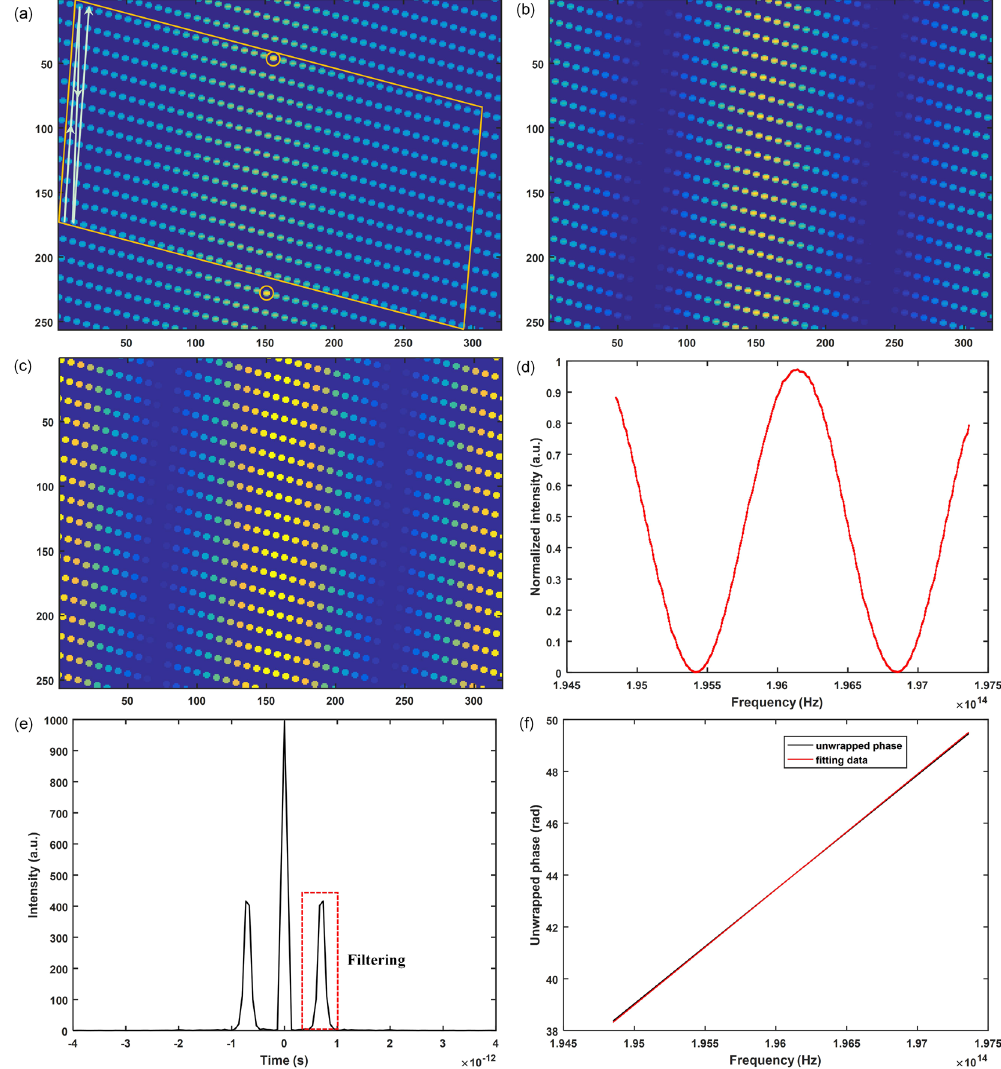
Figure 2. 2D spectrogram and data computing process. ( a ) Camera image of filtered comb spectrum, 1D spectrum is reconstructed by stitching vertical lines inside the orange box together, as indicated with the white arrow. ( b ) Camera image of spectral interferogram at a certain moment. ( c ) Camera image normalized by filtered comb spectrum. ( d ) Reconstructed 1D spectra interferogram. (e) Fourier transform of the reconstructed spectral interferogram. ( f ) The unwrapped phase. In ( a – c ), yellow represents higher optical